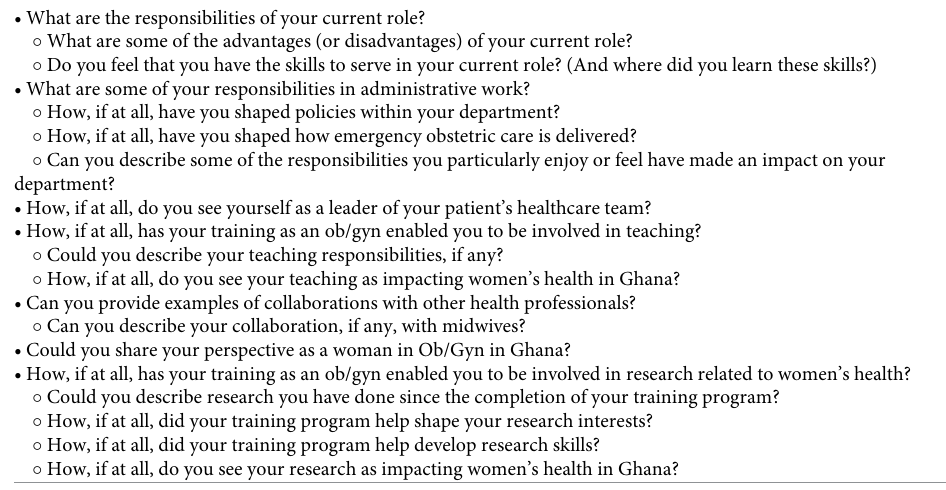
Table 1. Interview questions pertaining to graduate retention and career development. Selected questions from interview guide that contributed to this additional data analysis and model